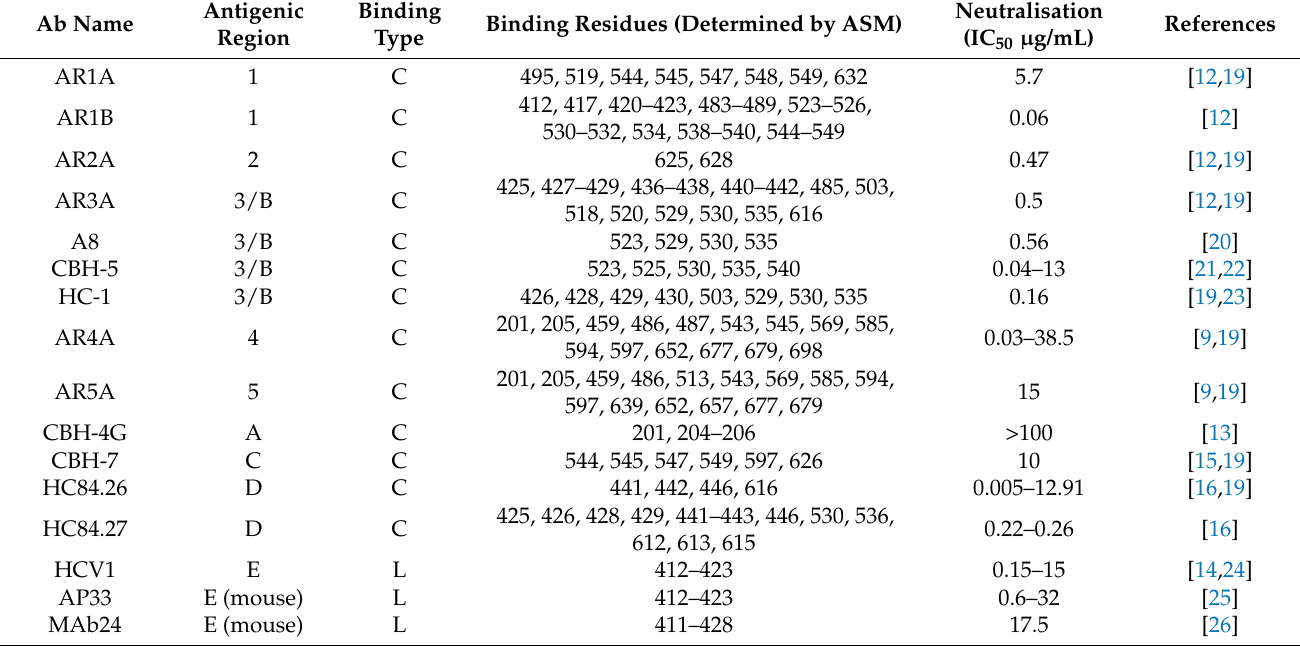
Table 1. Common human mAbs specific to a range of HCV E2 (and E1) epitopes. Included are antigenic regions (1–5), as defined by Giang et al. [9]; and antigenic domains (A–E), as defined by Keck et al. [10]. Target epitope type was either conformational (C) or linear (L). The binding residues indicate probable binding residues as assessed by alanine scanning mutagenesis (ASM). Neutralisation shown as the half-maximal inhibitory concentration (IC 50 ) of